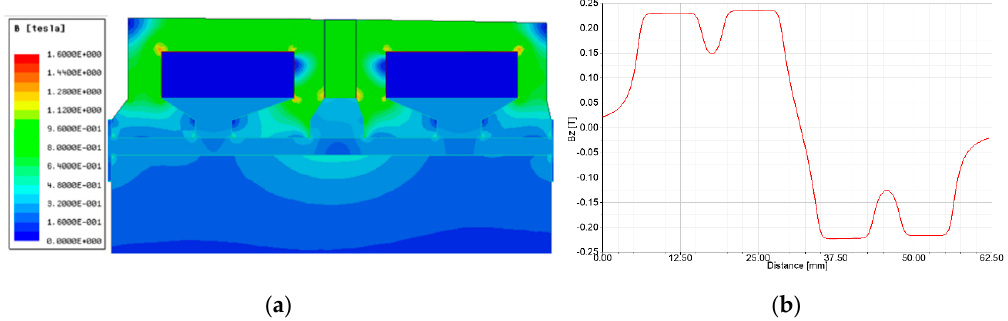
Figure 5. Flux density in the upper AHMB side with no excitation ( 𝑔 ∗ = 2 mm, Δ𝑔 = 0); ( a ) map of the magnitude; ( b ) axial component in the air-gap.